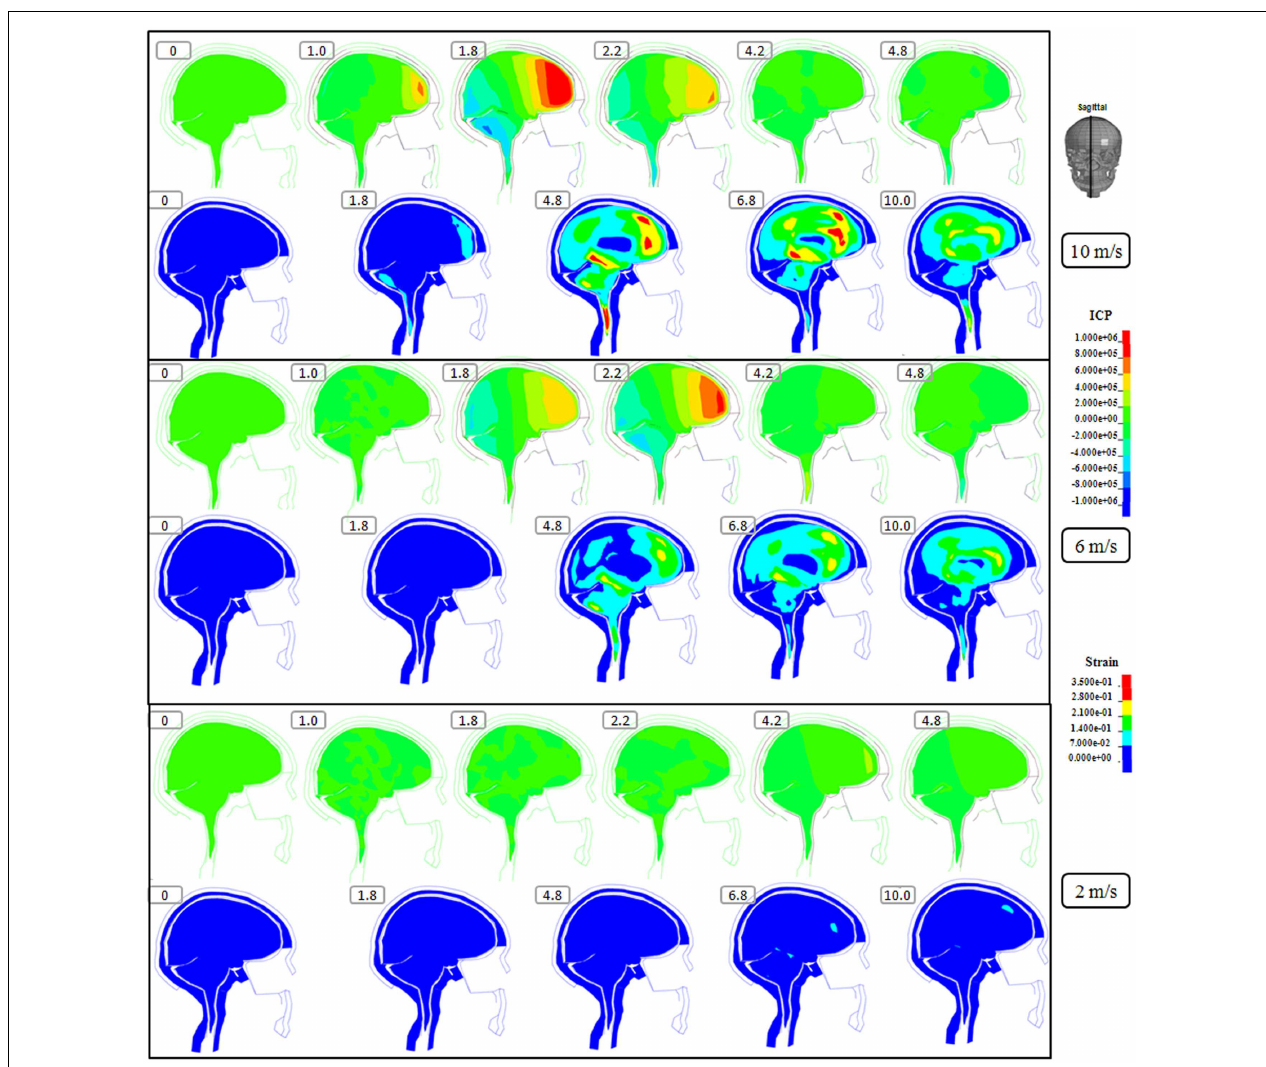
The location of the sagittal slice is indicated in the figure.The numbers included in the figure represent the time after the impact with unit of